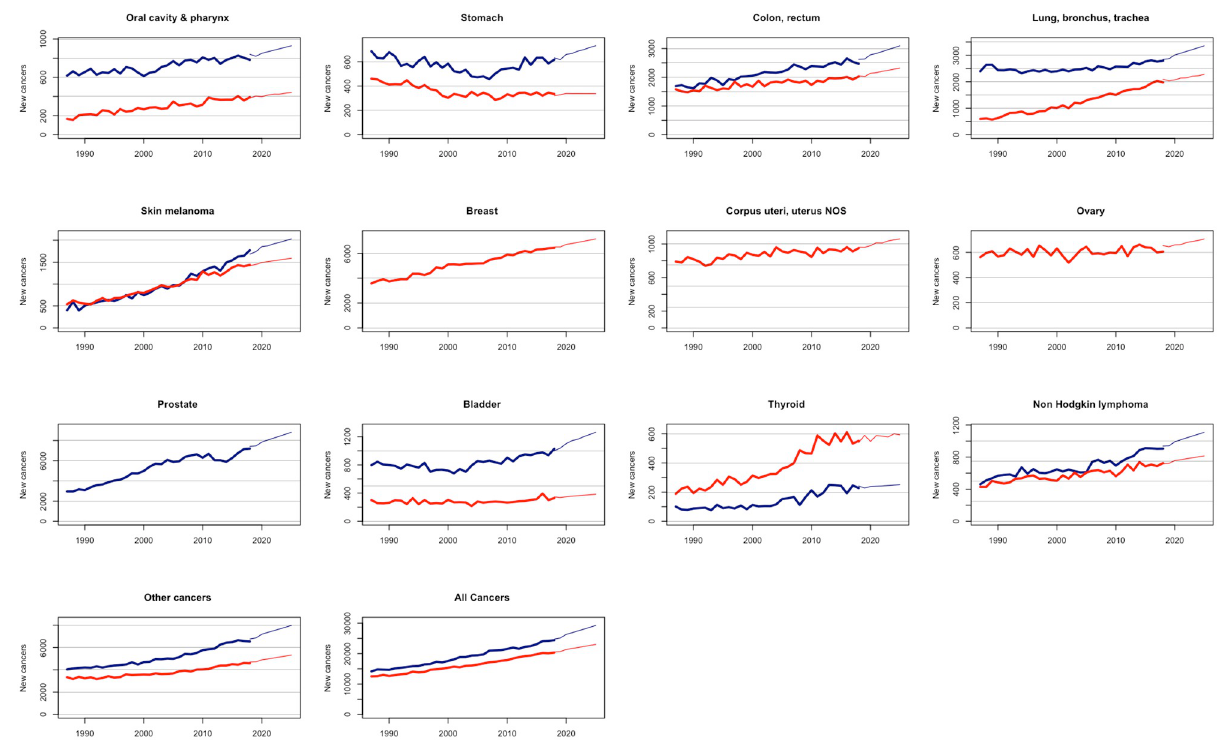
Fig 2. Observed and projected numbers of new cancer cases for all cancers and 12 cancer sites in Switzerland. Bold lines represent actual numbers; thinner lines represent projected numbers. Men in blue; women in red.